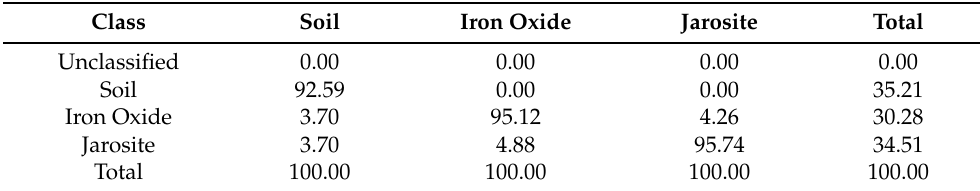
Table A13. July 2019 spectral angle mapper. Overall accuracy points: 134/142, overall accuracy: 94%, kappa coefficient: 0.9152.